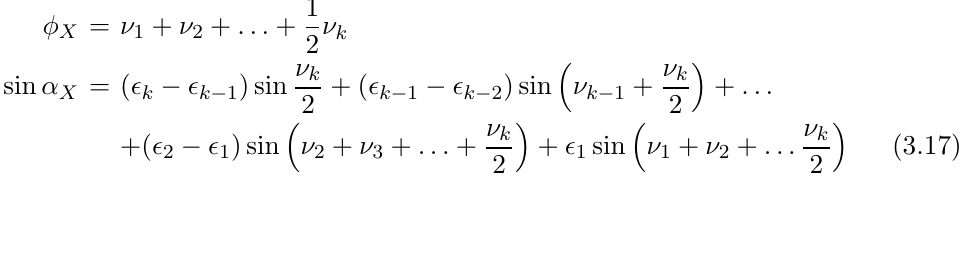
The same formulae hold for the antineutrino oscillation probabilities, after replacing (cid:14) ! (cid:0) (cid:14) and using e(cid:11)ective parameters (cid:22) (cid:30) below and eq.